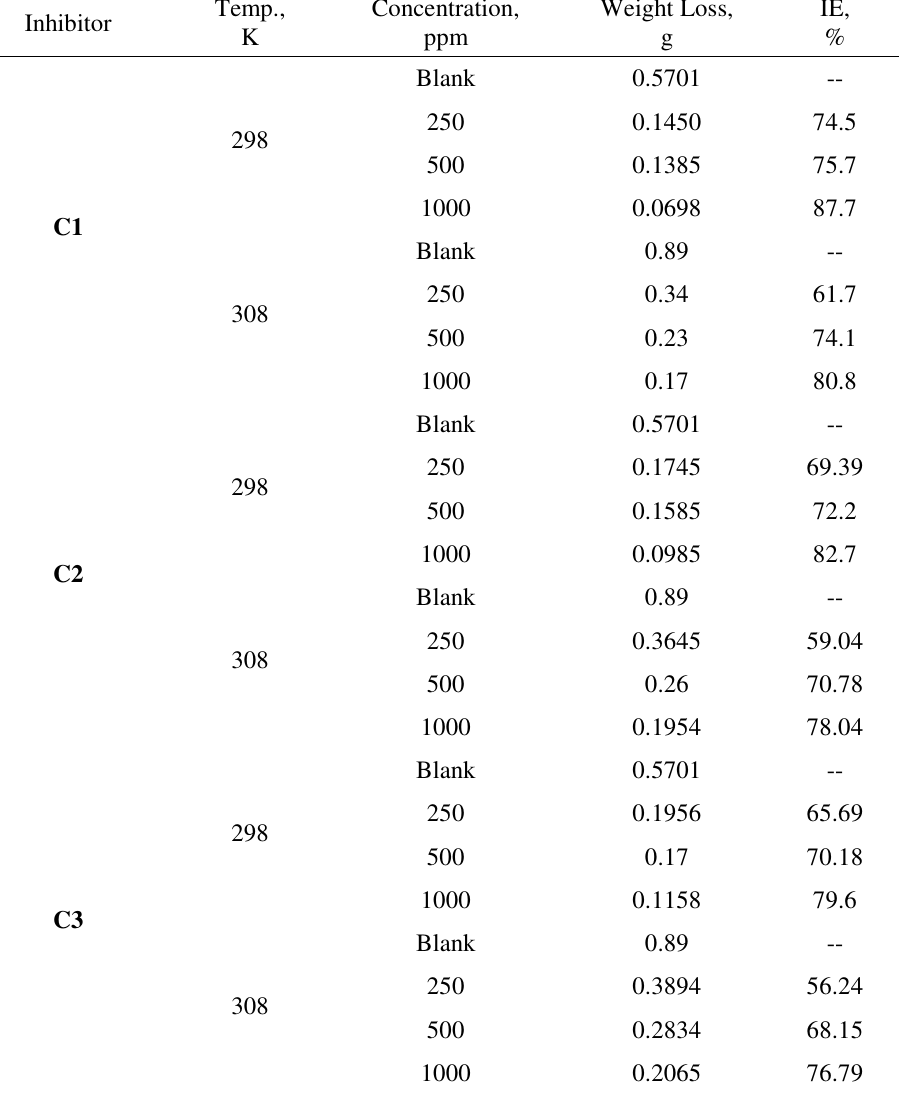
Table 1. Corrosion parameters obtained from weight loss measurements of various inhibitors taken at different concentrations and different temperatures in 0.5 N